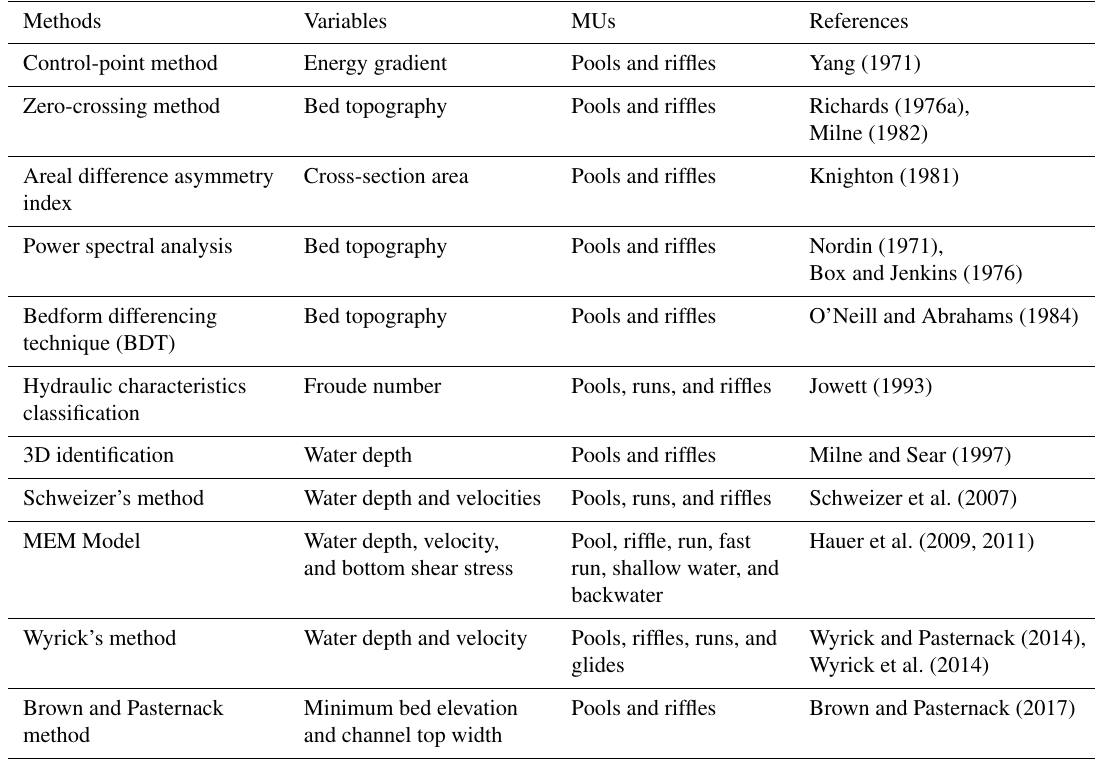
Table 1. Review of some methods of morphological units’ identification (variable used and MU